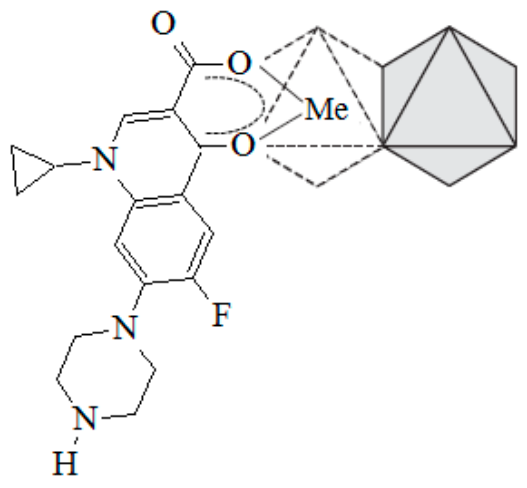
Figure 8. Representation of the structure proposed for the interaction between CPX − and atoms of metals on the PILC surface.